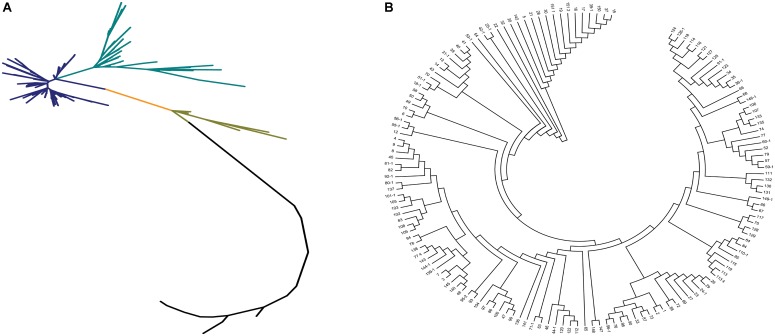
The phylogenetic tree of the 150 accessions of landraces in the Ting’s core collection. (A) The neighbor-joining trees for the entire population. Each branch represents an accession of landraces and two vertex distant represents the genetic relationship between the two landraces and each color represents a class of closely related species. (B) The cluster analysis of the 150 accessions of landraces.